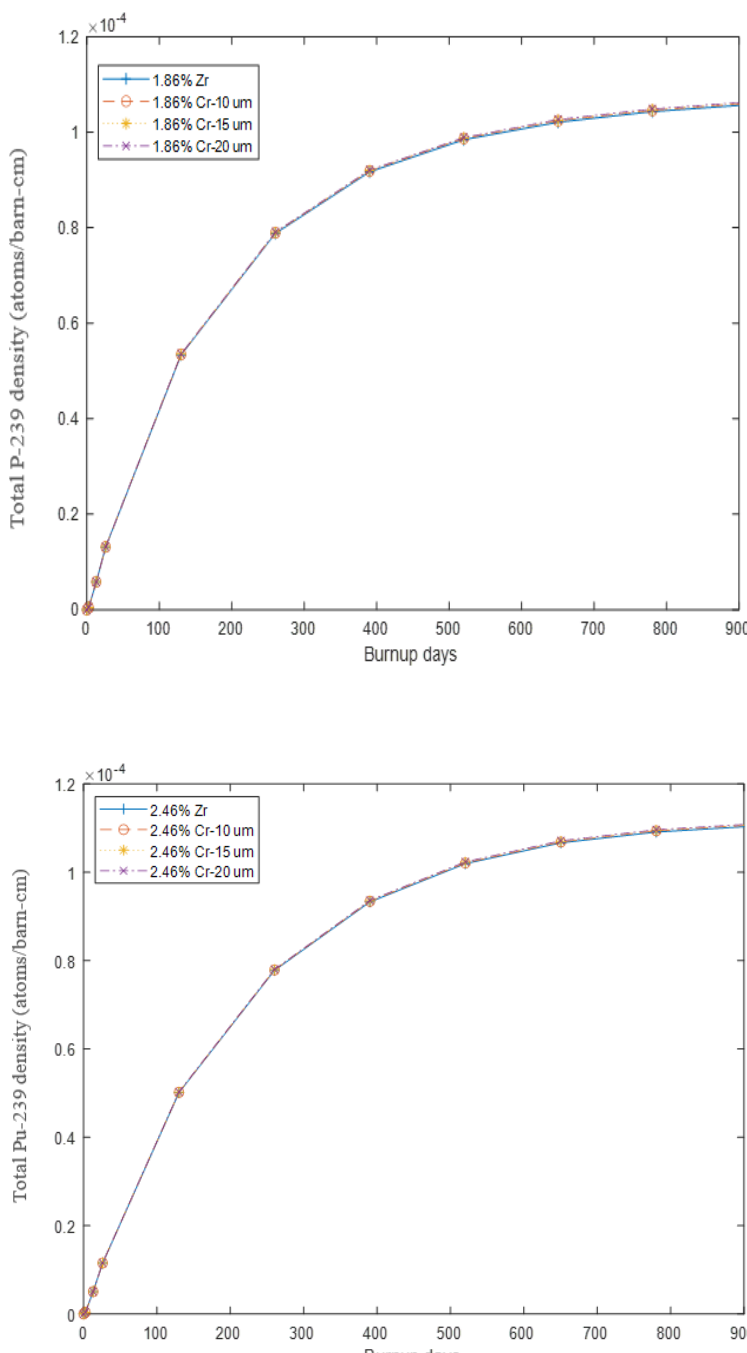
Figure 5. Evolution of Pu-239 inventory for Zircaloy and chromium-coating cladding systems.